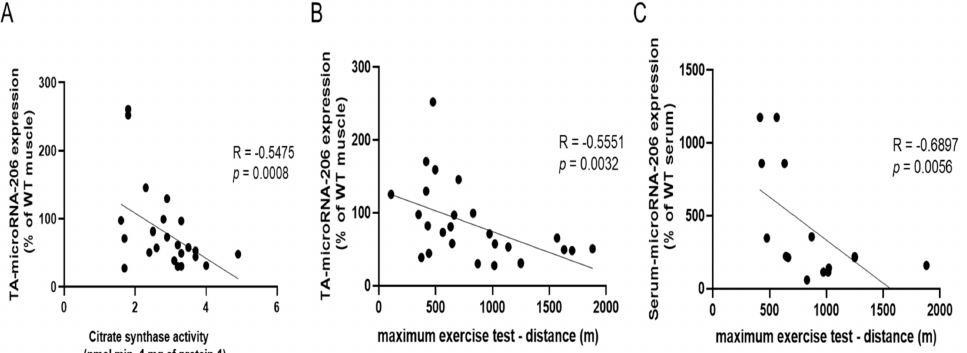
Figure 8. Correlations between microRNA-206 expression in the MMTV-PyMT model with training markers. ( A ) Correlation between TA microRNA-206 expression and citrate synthase activity. ( B ) Correlation between TA microRNA-206 expression and aerobic capacity (distance obtained in the maximum exercise test). ( C ) Correlation between serum microRNA-206 expression and aerobic capacity (distance obtained in the maximum exercise